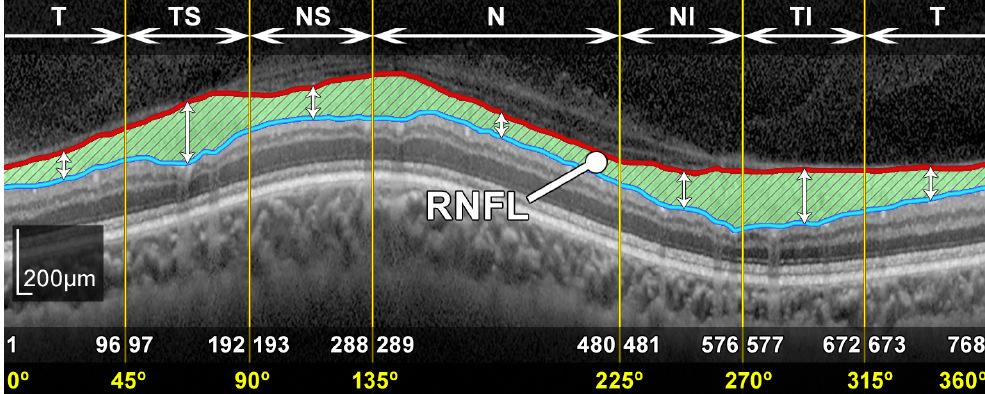
Figure 1. Segmented RNFL in a peripapillary B-scan OCT image. Relations of the sectors (T, TS, NS, N, NI and TI) measured in degrees and